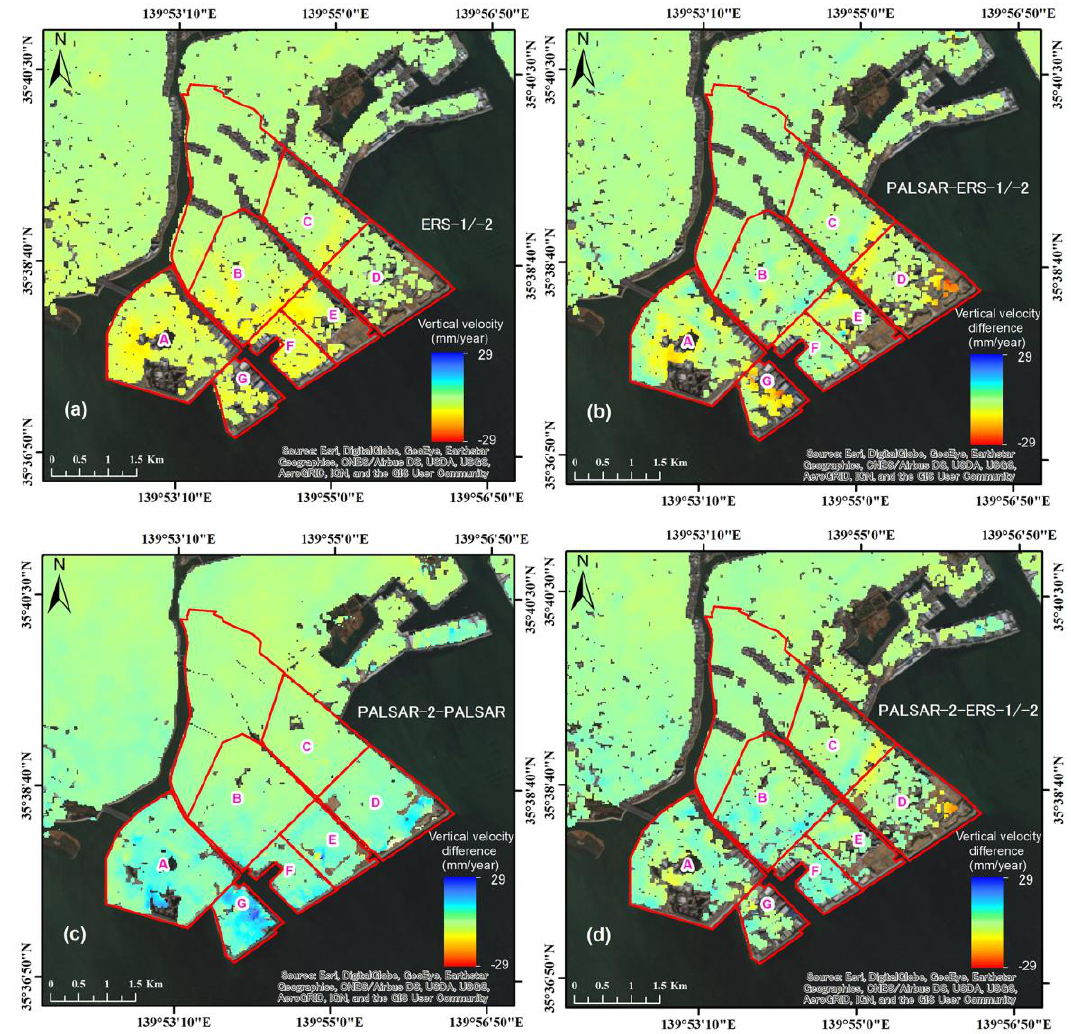
Figure 13. The spatial distribution map of difference of land subsidence rates during the three observation periods: ( a ) ERS-1/-2 derived subsidence rate using the SBAS method; ( b ) difference between ERS-1/-2 and PALSAR derived subsidence rates (subtracting ERS-1/-2 from PALSAR); ( c ) difference between PALSAR and PALSAR-2 derived subsidence rates (subtracting PALSAR from PALSAR-2); ( d ) difference between ERS-1/-2 and PALSAR-2 derived subsidence rates (subtracting ERS-1/-2 from PALSAR-2).